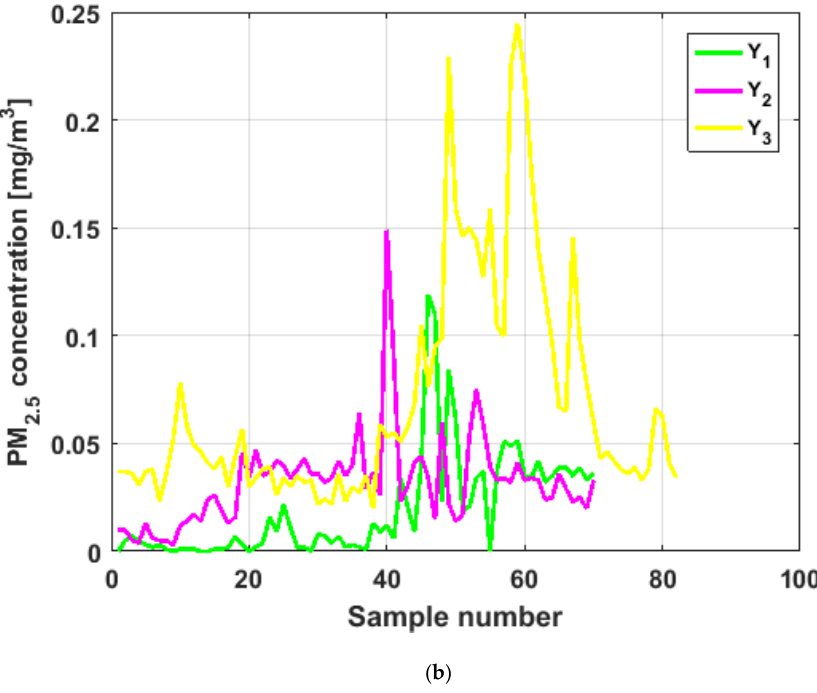
Figure 4. Graphs of the data obtained during the data collection process: ( a ) PM 2.5 concentration measurements of X 1 , X 2 , and X 3 ; ( b ) PM 2.5 concentration measurements of Y 1 , Y 2 , and Y 3 .